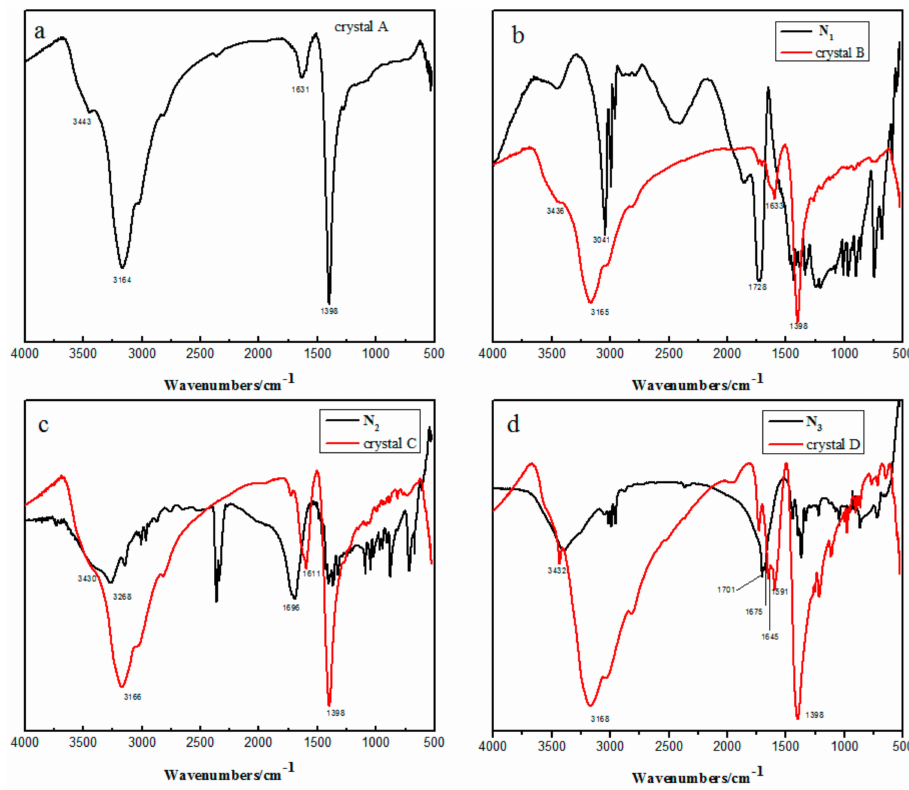
Figure 3. FT-IR spectra of the N 1 , N 2 , N 3 and crystal A-D. ( a ) crystal A; ( b ) N 1 and crystal B; ( c ) N 2 and crystal C; ( d ) N 3 and crystal D.